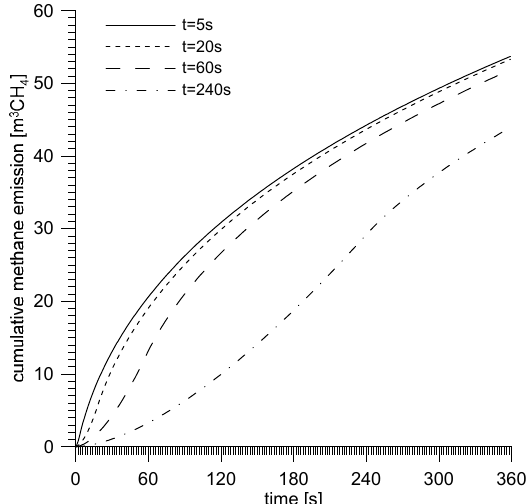
Figure 17. Model cumulative methane emissions determined based on a sphere during the Budryk outburst.